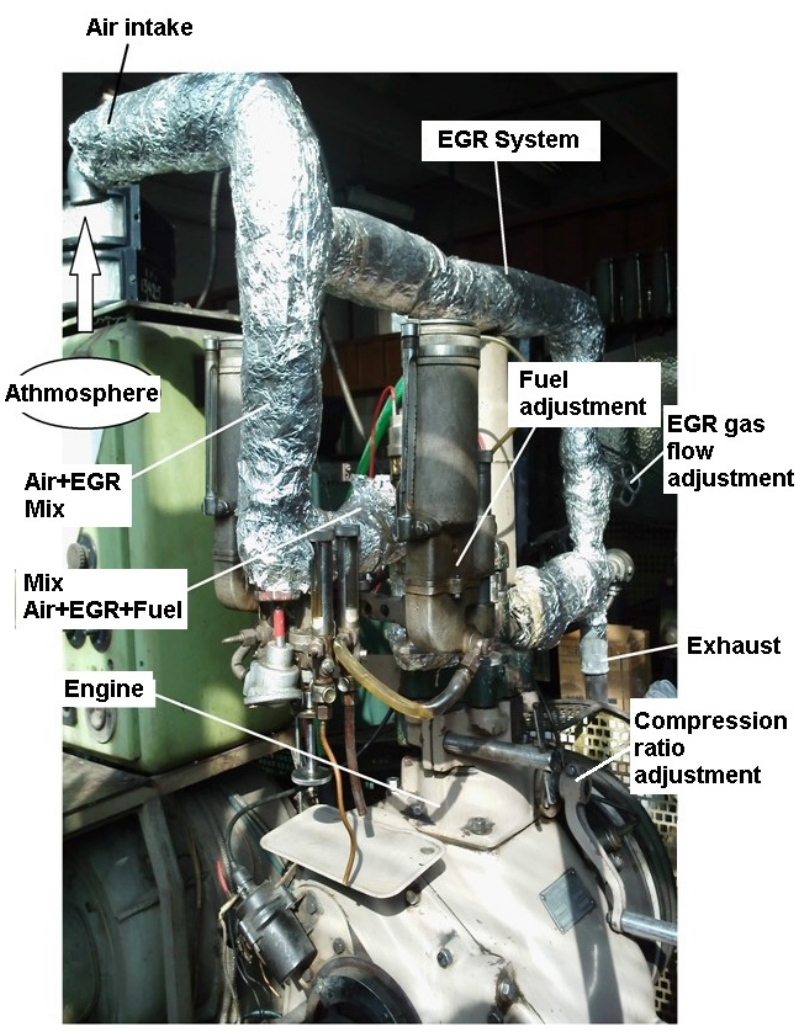
Figure 1. Experimental setup of the engine. The engine characteristics are listed in Table 1. The fuel supply to the engine is achieved by a carburetor